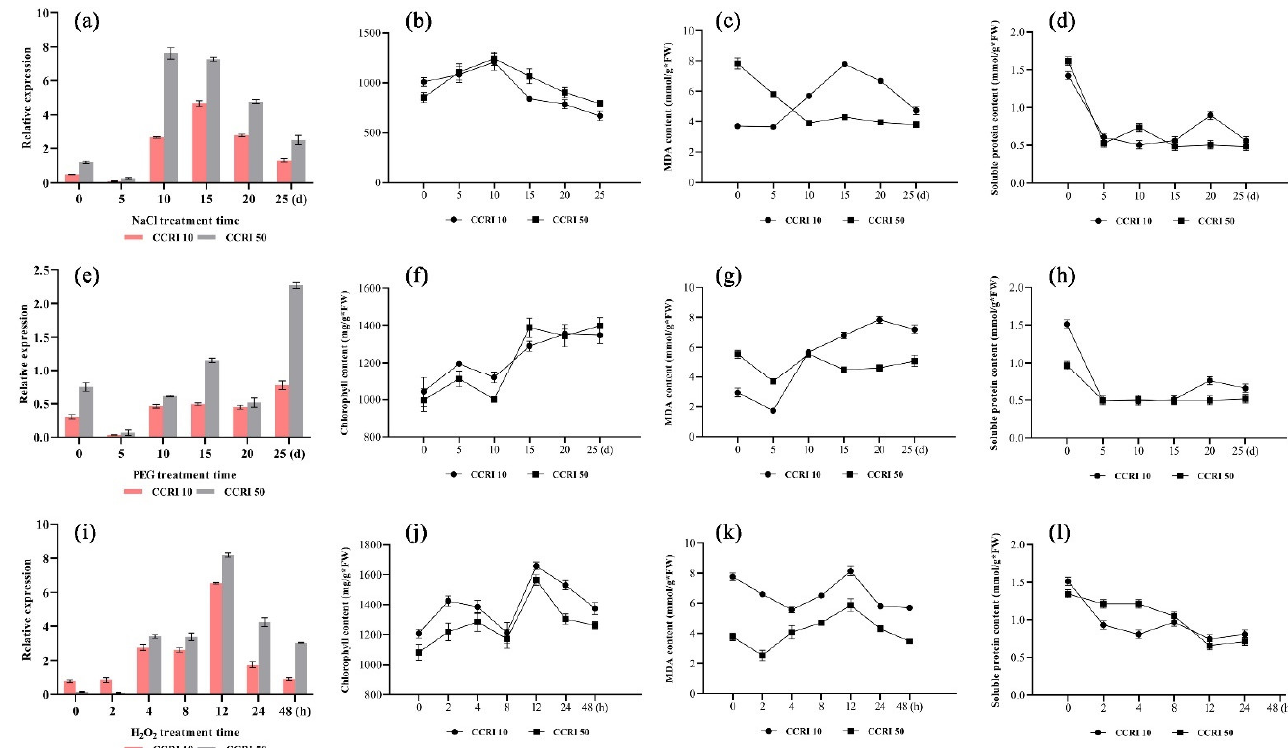
Figure 5. Expression patterns and related physiological metrics changes of GhNAC82 after salt, drought, and H 2 O 2 stress. ( a , e , i ) Expression pattern of GhNAC82 under NaCl, PEG, and H 2 O 2 treat- ment; ( b , f , j ) Changes of chlorophyll content under treatments; ( c , g , k ) Changes of malondialdehyde content under treatments; ( d , h , l ) Changes of soluble protein content under treatments.